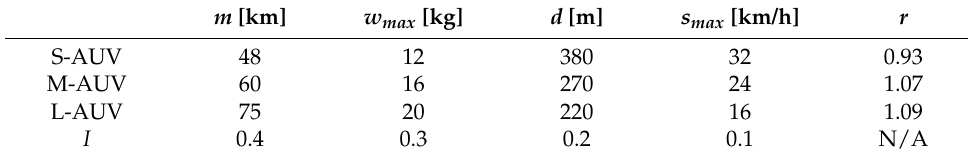
Table 1. Four main technical parameters of the three types assumed AUVs. m [km] w max [kg] d [m] s max [km/h] r S-AUV 48 12 380 32 0.93 M-AUV 60 16 270 24 1.07 L-AUV 75 20 220 16 1.09 I 0.4 0.3 0.2 0.1